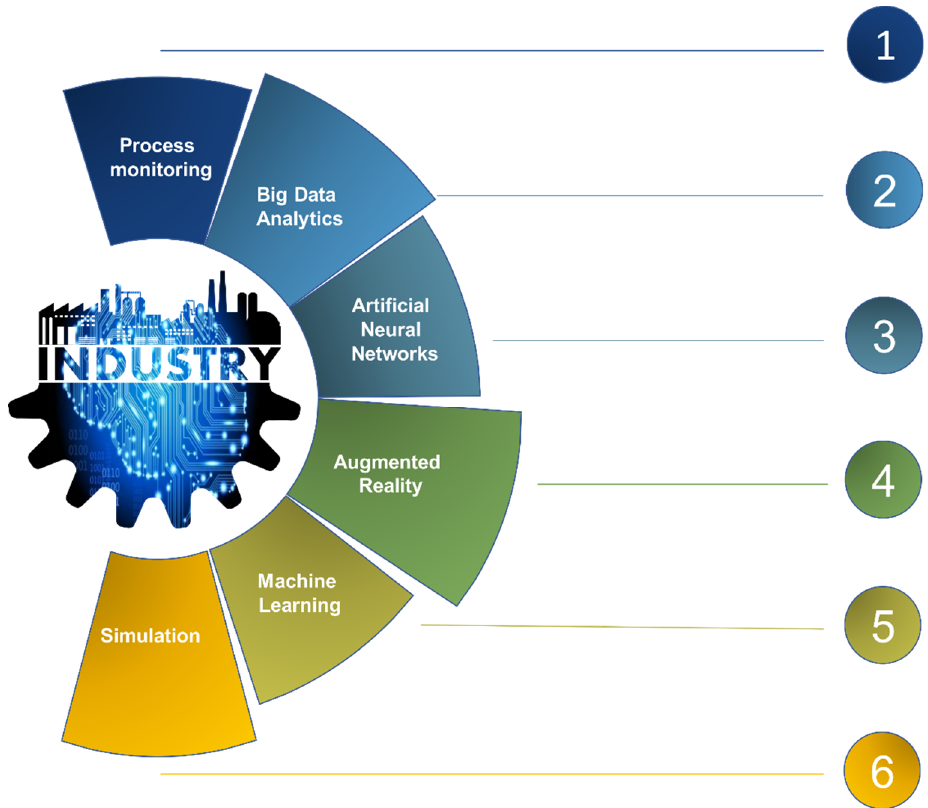
Figure 39. Industry 4.0 tools for FSW and FSSW processes understanding, automation, and Figure39. Industry4.0toolsforFSWandFSSWprocessesunderstanding, automation, optimization.